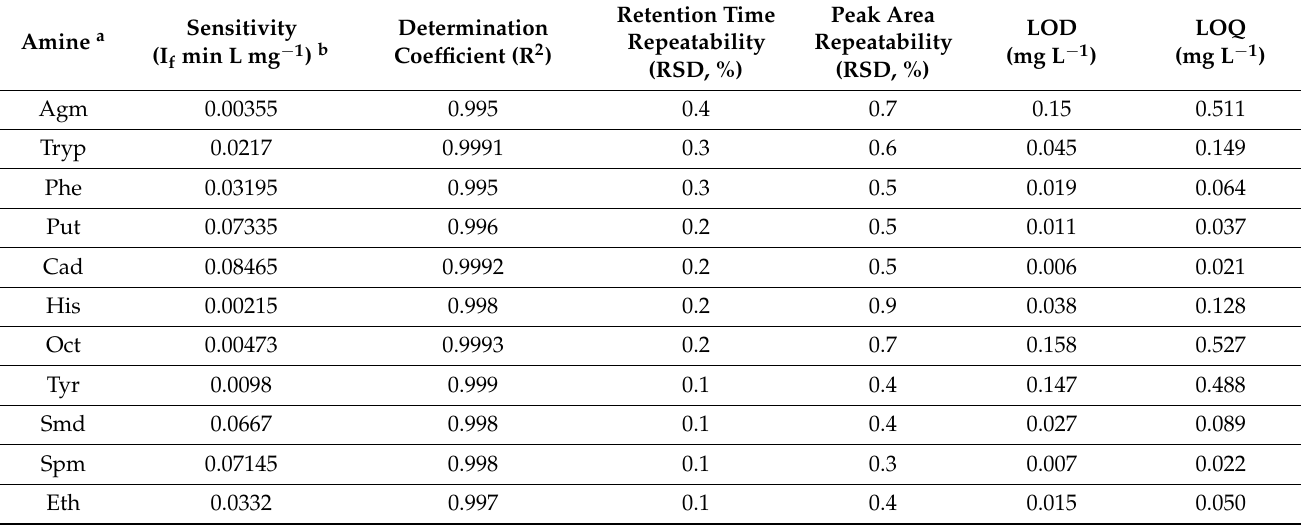
Table 2. Quality parameters obtained for the derivatized amines using the HPLC–FLD optimized method.